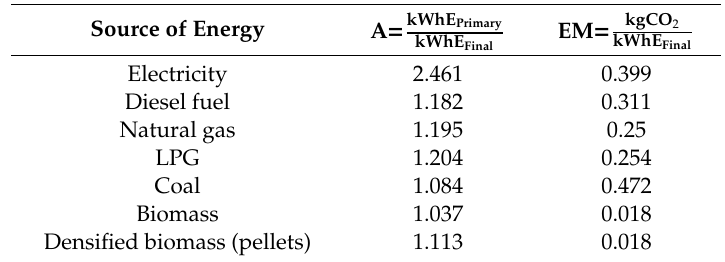
Table A10. Transfer coe ffi cients and emission factors [40]. LPG—liquid petroleum gas.